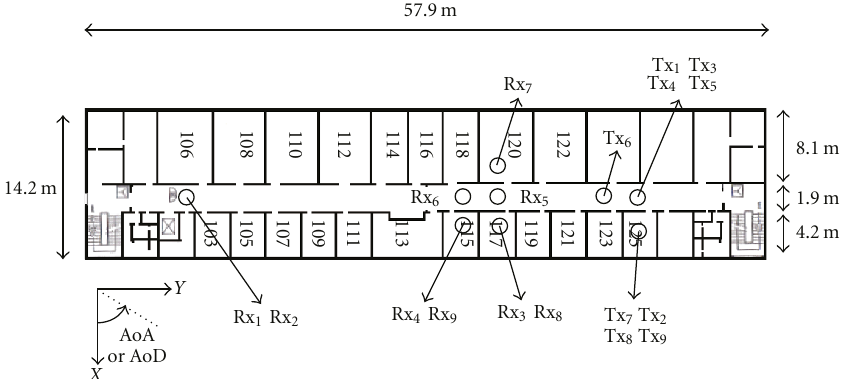
Figure 2: Floor plan of the measurement environment with Tx and Rx locations.